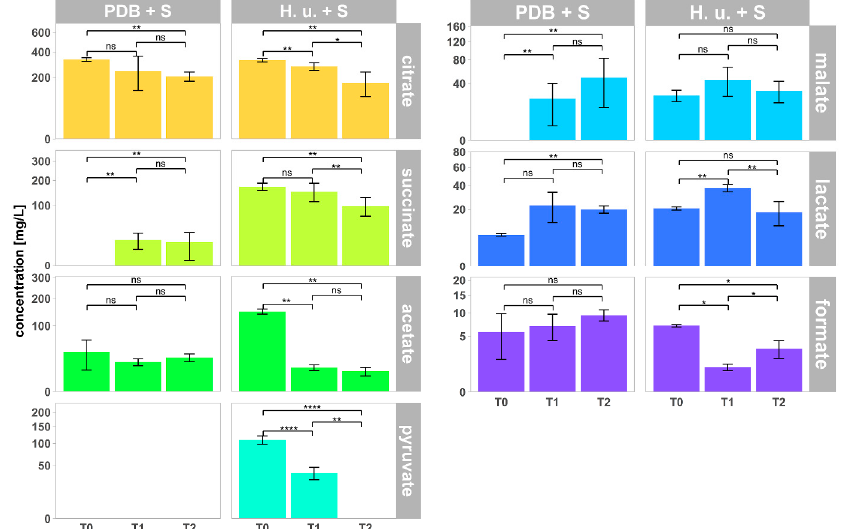
Figure 6. Concentration of organic acids (mean ± SD; n = 5) in the culture broth PDB + S (T0), in the fermentation broth H. u. + S (T0) and on the surface of leaves treated with PDB + S and H. u. + S collected one day (T1) and one week (T2) after treatment. Pyruvate was not detected at any of the timepoints in PDB + S. Succinate and malate were not detected at T0 in PDB + S. Asterisks indicate significant differences between timepoints for each treatment ( p < 0.05). Not significant differences are reported, as well